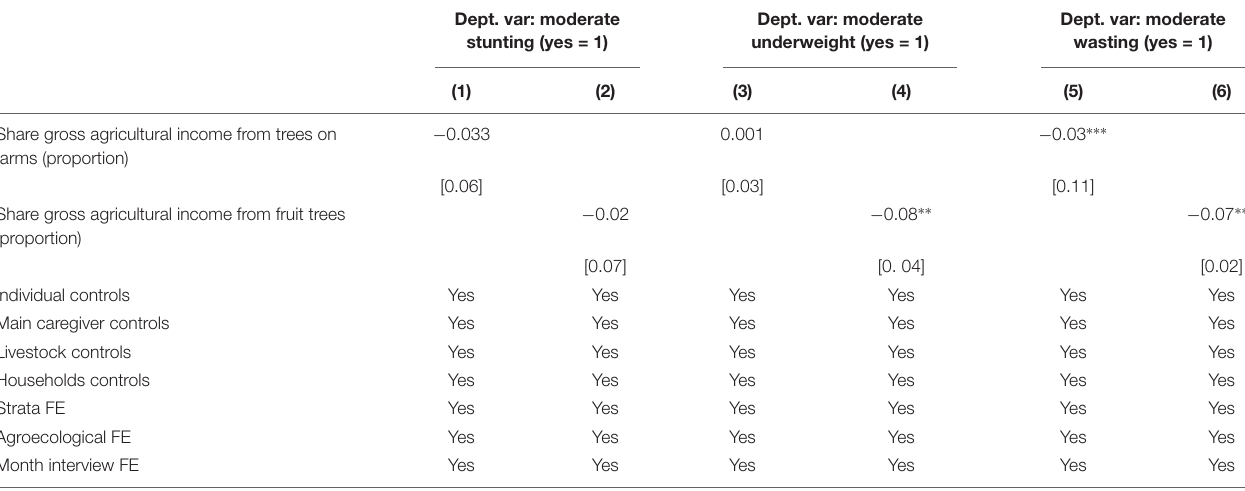
TABLE 6 | Probit estimates for the relationship between health and nutrition status for children between 6 and 59 months old and the presence of trees on farms (marginal effects).